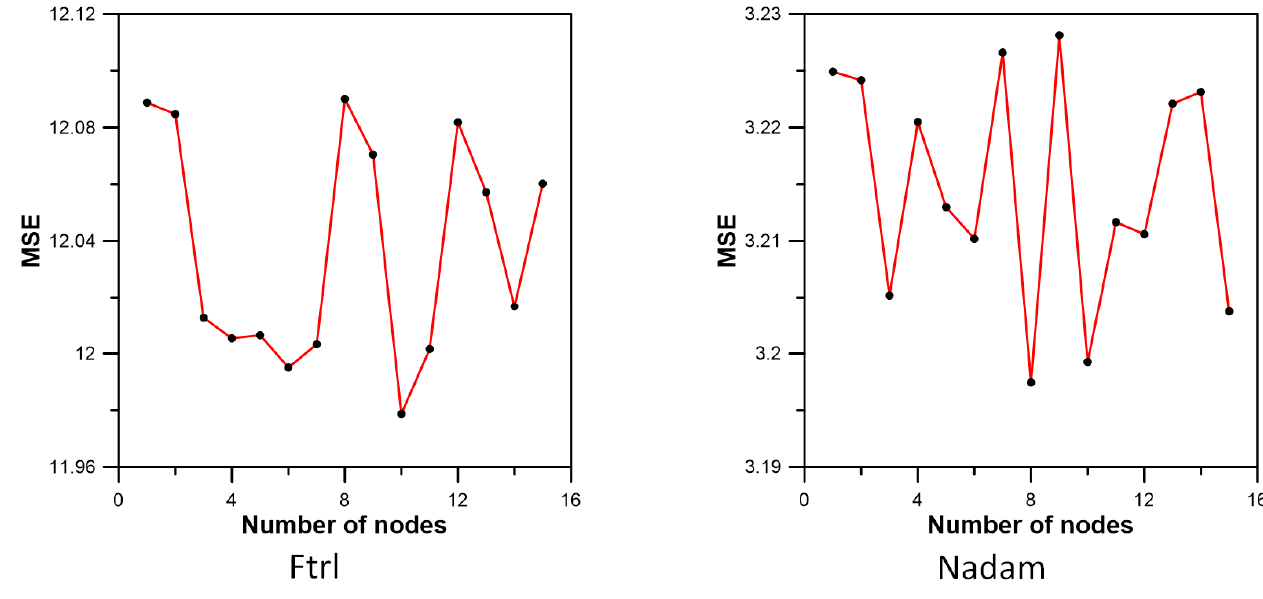
Figure 13. Results according to the number of nodes (Ftrl and Nadam).